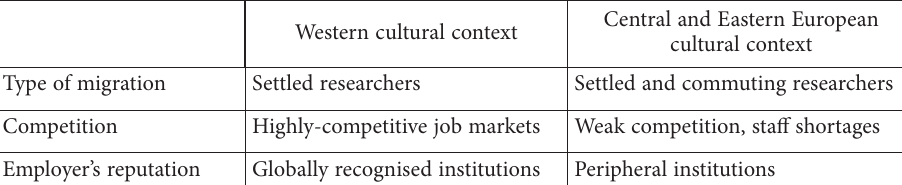
Table 1. Knowledge transfer via international migration in Western Europe and Central and Eastern Europe (source: created by